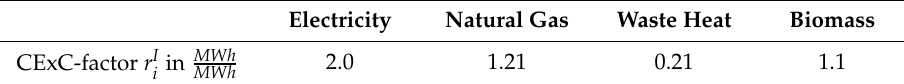
Table 1. CExC-factors for the different imported energy carriers [27].